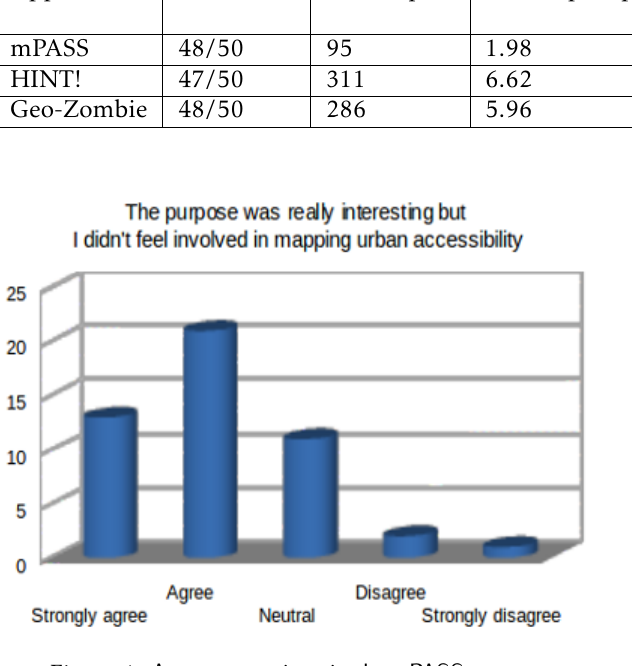
Figure 4. Answers to a item in the mPASS survey Figure 5. Answers to a item in the HINT! survey